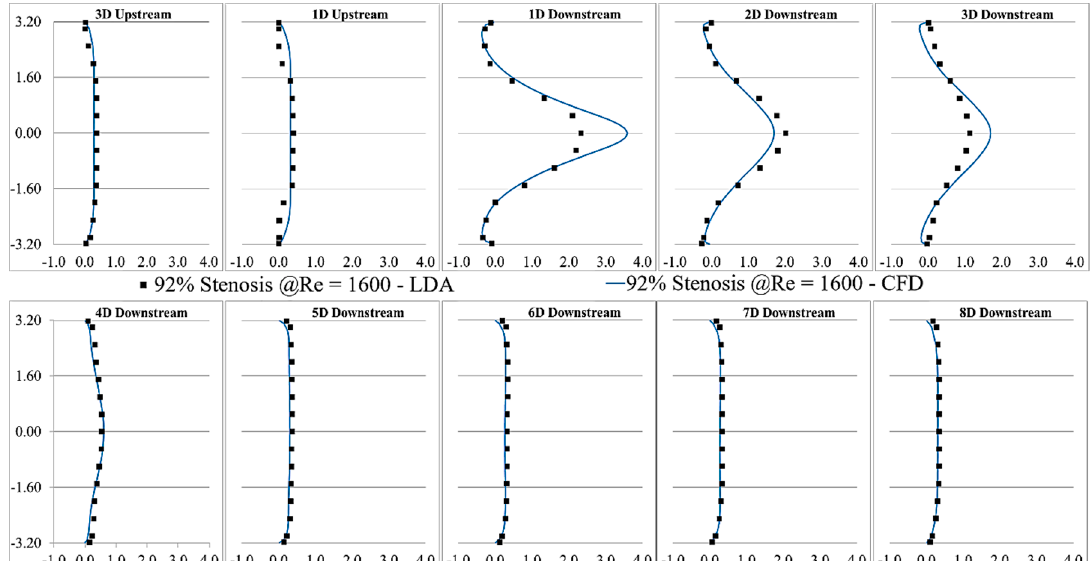
Figure 4. Validation of the CFD results of 92% stenosis at Re = 1600 compared with the LDA measurements. Based on the study of mesh independency, the mean wall pressure variation along the wall in the post-stenotic region was also examined. The final result of the mean pressure at the wall was shown in Figure 5. It was compared with a previous experimental study [26] in which a catheter-type pressure transducer was used, which was able to collect the mean and fluctuating pressure signals within the vessel lumen. The results showed good agreement for both the wall pressure differences and the location of the maximum pressure. As the blood flow entered the expansion region, the pressure distribution changed significantly, leading to a wall pressure difference of about 700 Pa between the stenosis and flow domain exits. Additionally, the mean wall pressure reached its maximum value at about 25 mm (or, x = 4D); after which, it decreased gradually to the exit.